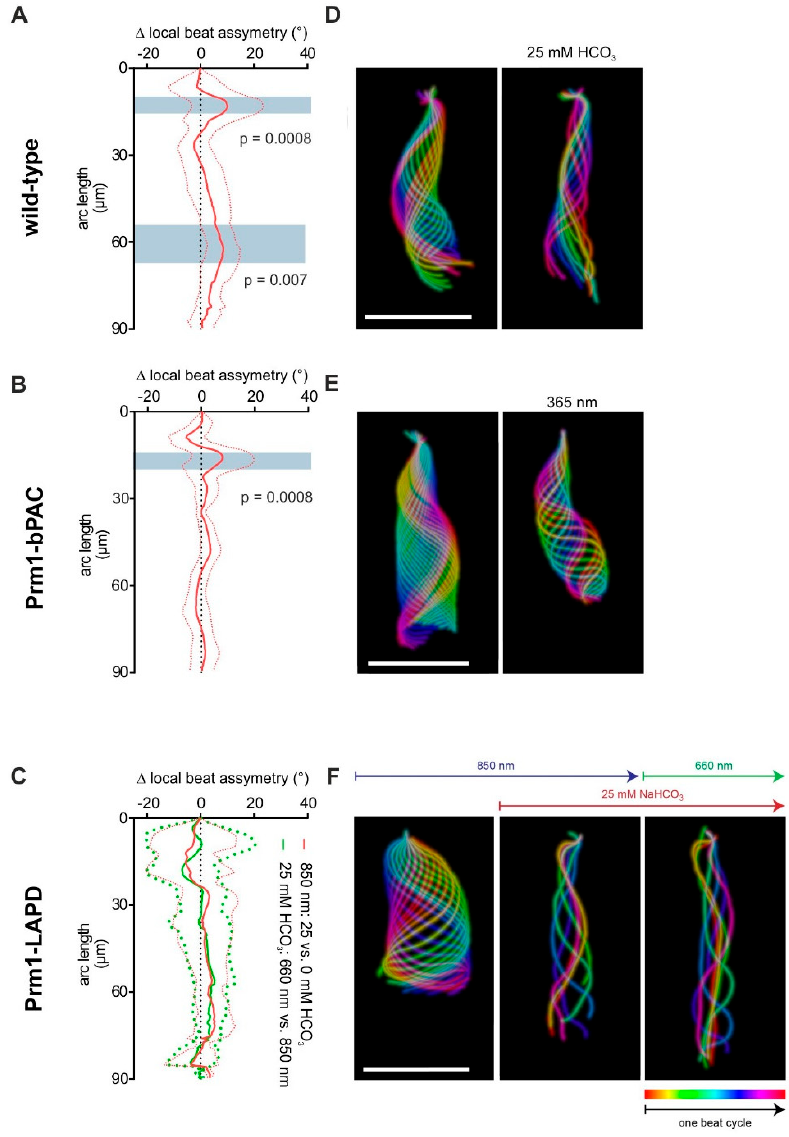
Figure 4. Using optogenetics to control sperm motility. ( A ) Local beat asymmetry, determined at each flagellar position by the absolute of the time-averaged curvature angle. Wild-type sperm (WT) were analyzed before and 1 min after stimulation with 25 mM NaHCO 3 (850 nm). Plotted is the difference before and after stimulation as mean (dark red line) ± S.D. (light red line). ( B ) Local beat asymmetry Prm1-bPAC sperm before and after 10 s exposure to 365 nm light. Plotted is the difference after